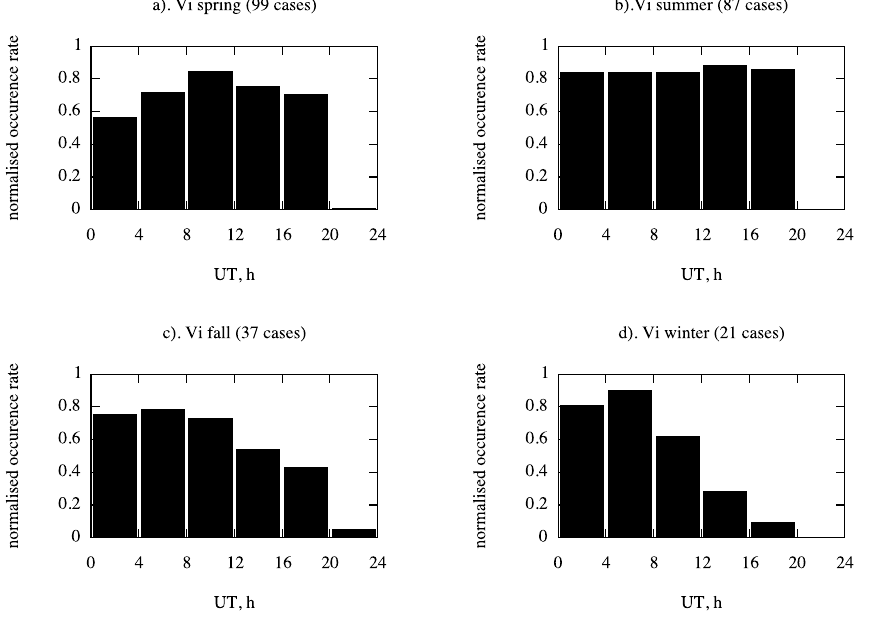
Fig. 14. AGW-TID occurrence rate as a function of UT for different seasons.